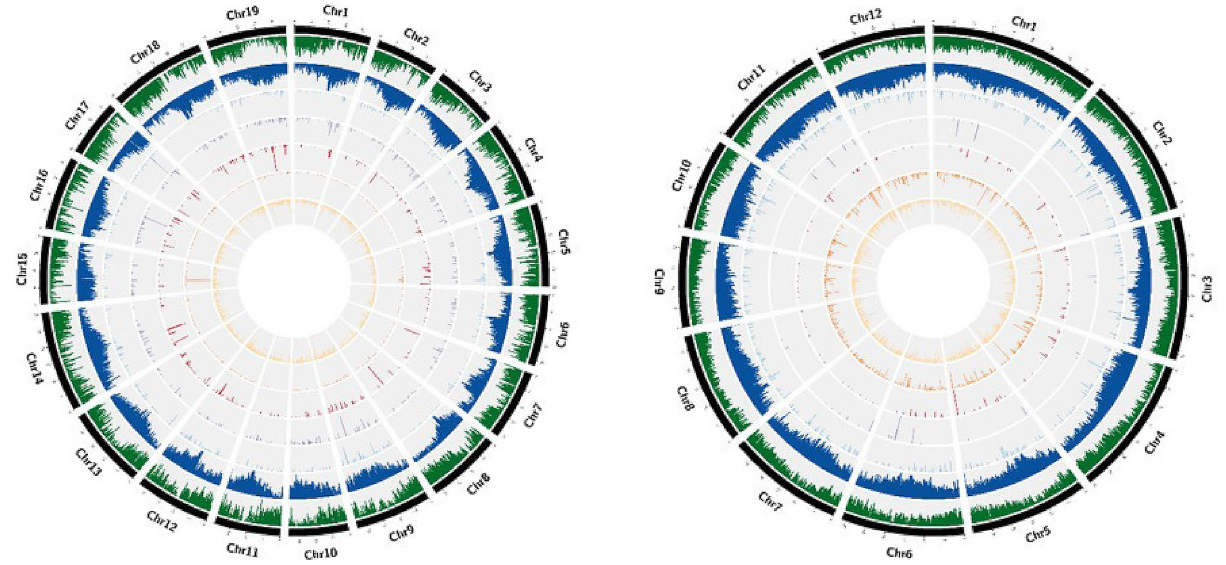
Figure 7. Circos graphs for distribution of genomic and features of the V. vinifera (left) and O. sativa (right) genomes. The histograms within each graph represent the densities of (from outer to inner): functional genes (green); transposon elements (blue); DUP pseudogenes; RET pseudogenes; AMB pseudogenes; single-exon pseudogenes; and FRAG